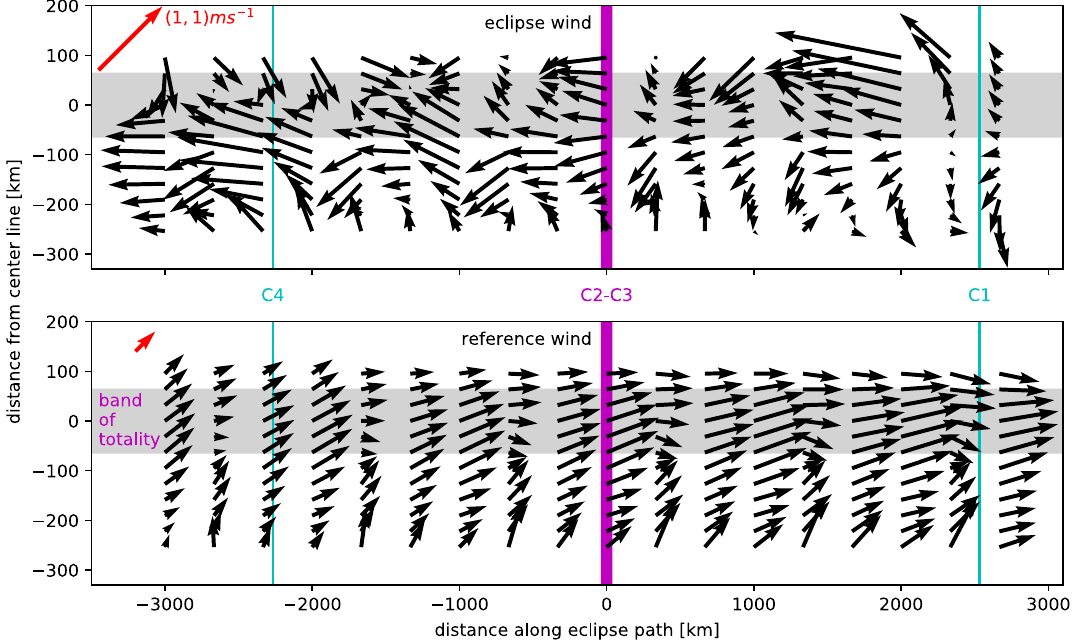
Figure 6. Vector wind as a function of distance along (x) the path of the eclipse and from the center line (y). Eclipse wind is the observed wind vector minus the reference estimate. The x distance is calculated from − 1 observation time assuming an umbral velocity of 2000 km h ; the positive direction points west to east as usual since the eclipse’s movement is also in this sense. The field is smoothed with biquadratic radial basis functions. While the x, y locations are non-square, the arrow lengths are isotropic; red arrows show the scale of the wind − 1 with u = v = 1 ms .